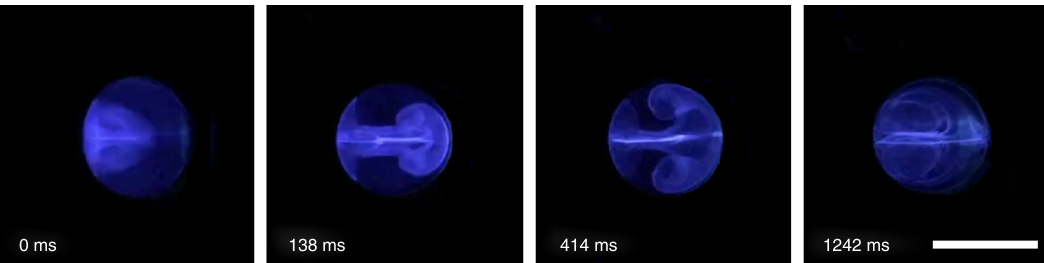
Fig. 4 Internal streaming within a droplet. A trapped 50 µ L droplet with super-signal ELISA luminescent substrate is merged with a droplet containing horseradish peroxidase (HRP). Two symmetric vortices are visualized by the luminescence emitted upon oxidization of the luminol substrate. The luminol- containing droplet was fi rst stabilized at one-pixel unit and then merged with a HRP-containing droplet. Luminescence was emitted instantly upon merging. Digital acousto fl uidics generates strong internal fl uidic streaming within the trapped droplets, thereby minimizing internal polarization in aqueous droplets and enabling ef fi cient mixing of merged droplets. Supplementary Movie 1 demonstrates the dynamic process of inner streaming. Scale bar: 5